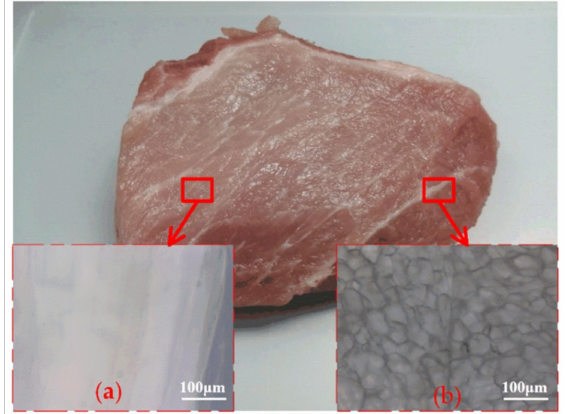
Figure 3. Major components of biological soft tissue: ( a ) muscle fibers; ( b ) connective